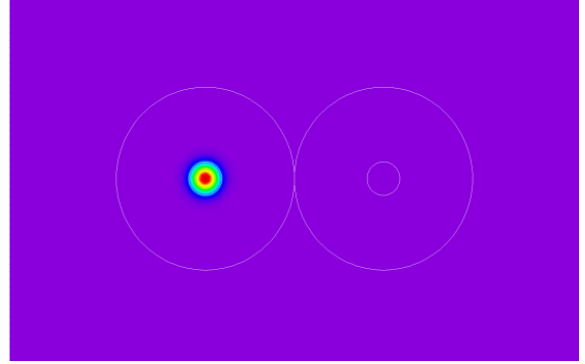
Figure 14. 2D power distribution map of the input port ( z = 0.0000 μm).